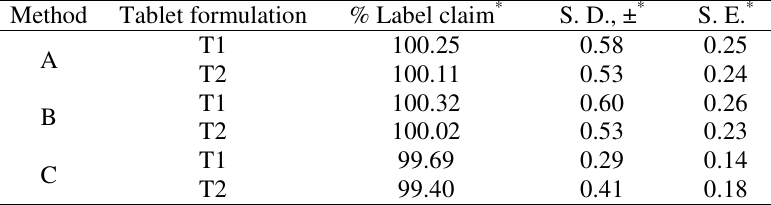
Table 2. Estimation itopride hydrochloride in tablet formulation